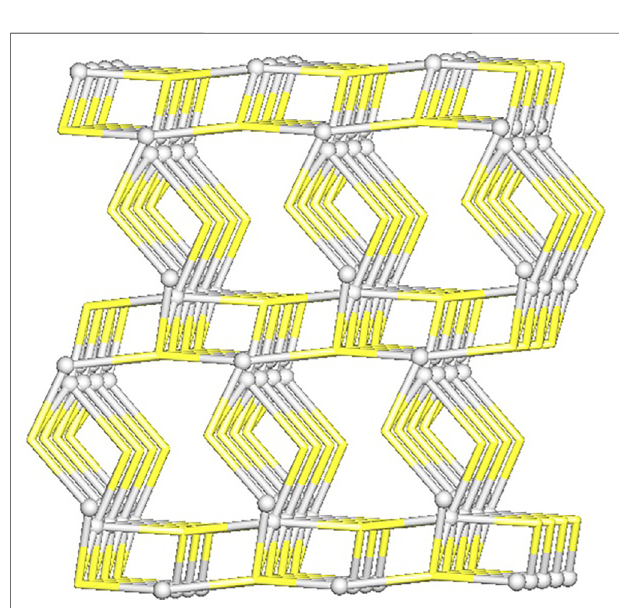
FIGURE 4 | Topological representation of a dinodal 3,4-linked net in [Ag(I)-Tazo] with a cbs (CrB self-dual) topology; rotated view along the b axis; Ag1/Ag2 centers (gray balls), centroids of µ 3 -and µ 4 -Tazo − moieties (yellow).